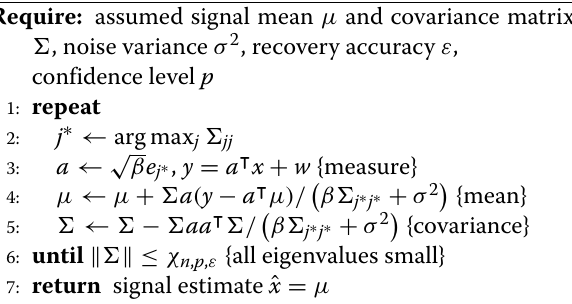
Algorithm 2 Info-Greedy Sensing with sparse